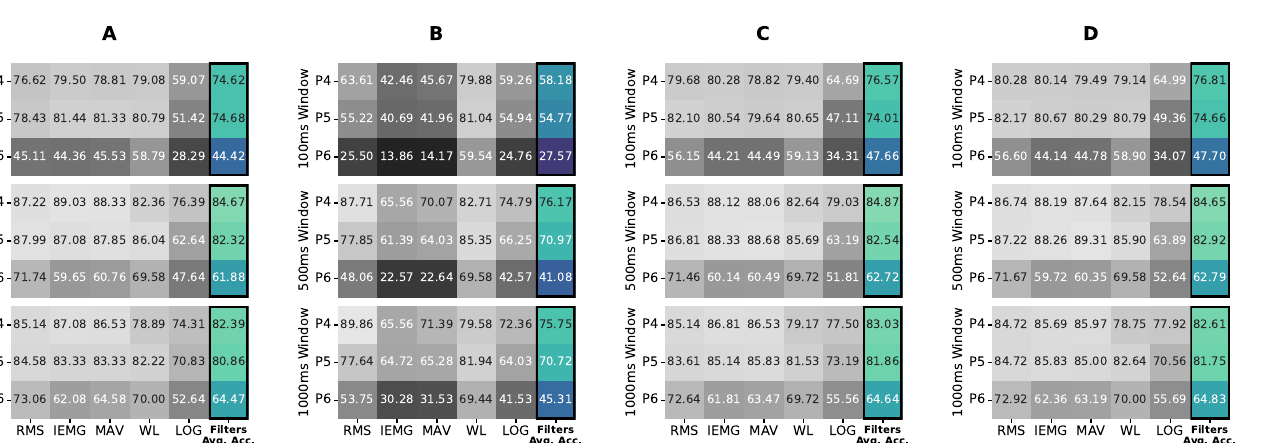
Figure 4. Averaged accuracies of logistic regression (LR), linear discriminant analysis (LDA), and quadratic discriminant analysis (QDA) for ( A ) no normalization, ( B ) (0, 1) normalization, ( C ) ( − 1, 1) normalization, and ( D ) ( − 2, 2) normalization on Participants 4, 5, and 6 data using non-tuned features with varying window sizes.